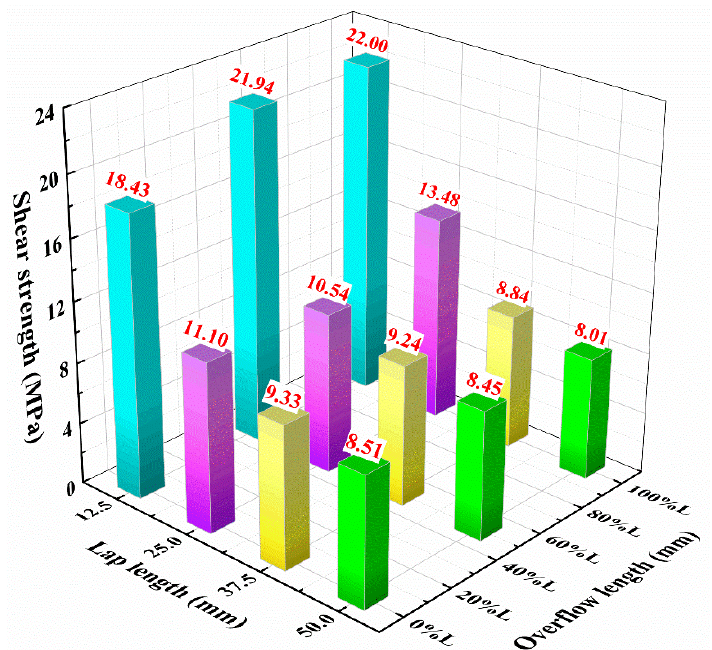
Figure 14. Effect of overflow length on tensile shear strength at different lap lengths.